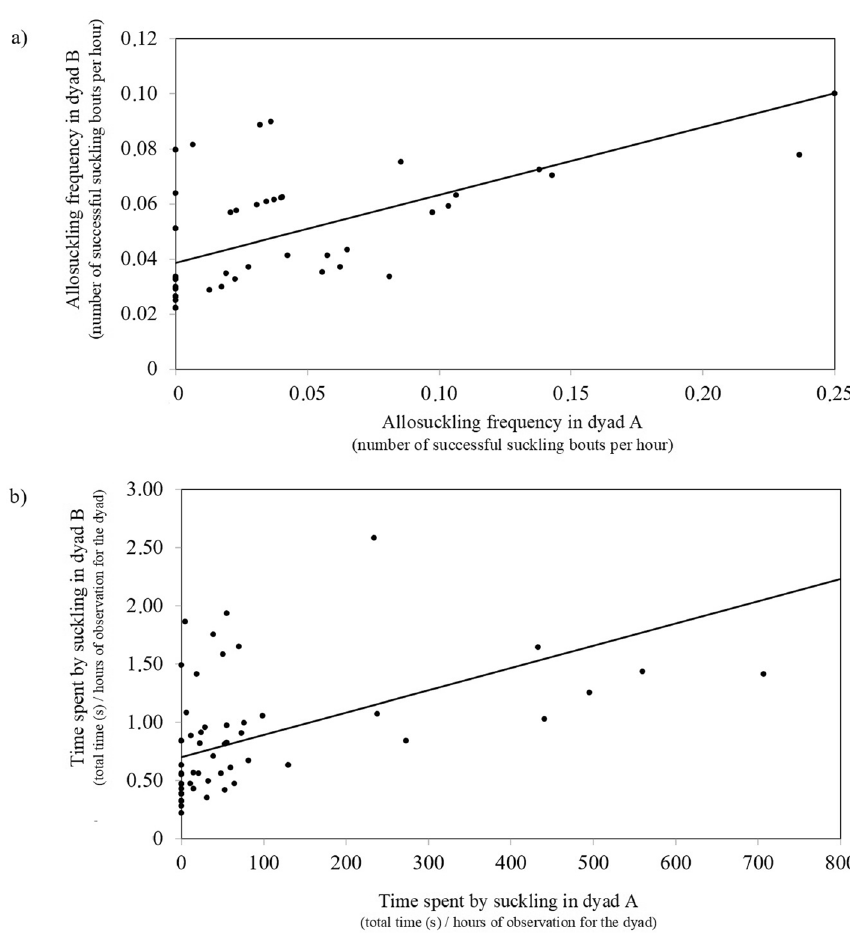
Figure 3. Allosuckling frequencies increased for both dyad A and B when compared ( a ). The same applied for the time devoted to allosuckling in the respective dyads ( b